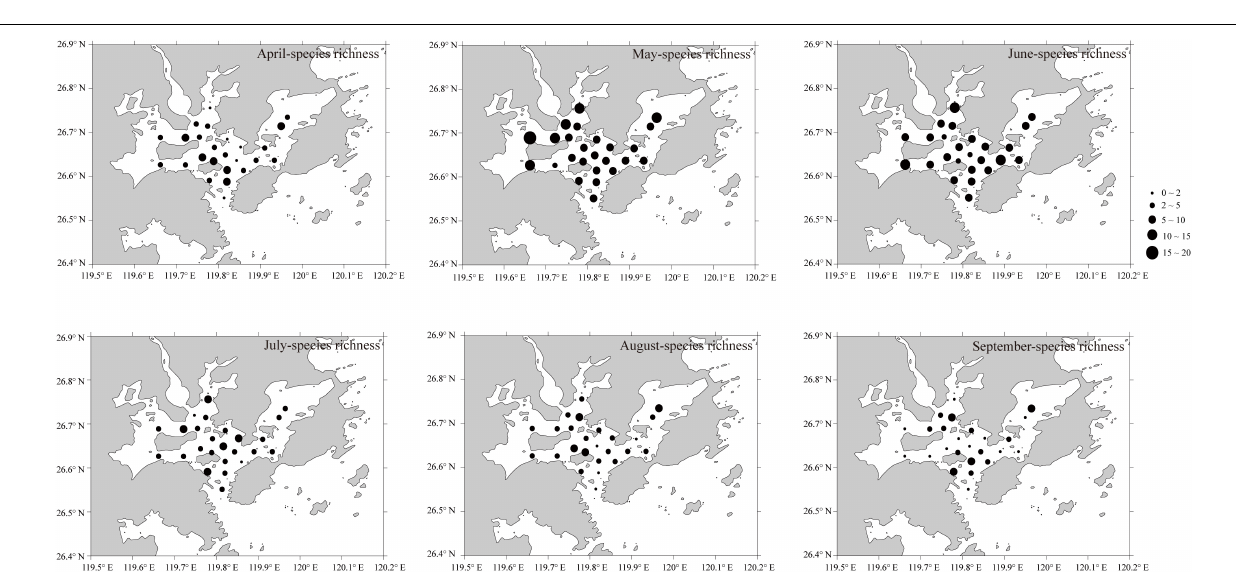
FIGURE 6 | Spatial variation of ichthyoplankton species richness from April to September 2019 in Sansha Bay of Fujian Province,